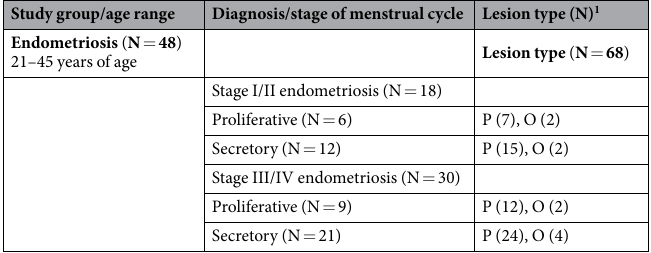
Table 1. Patient Demographics. 1 N indicates the number of each lesion type within group. Abbreviations: P = peritoneal biopsy; red lesion, O = ovarian